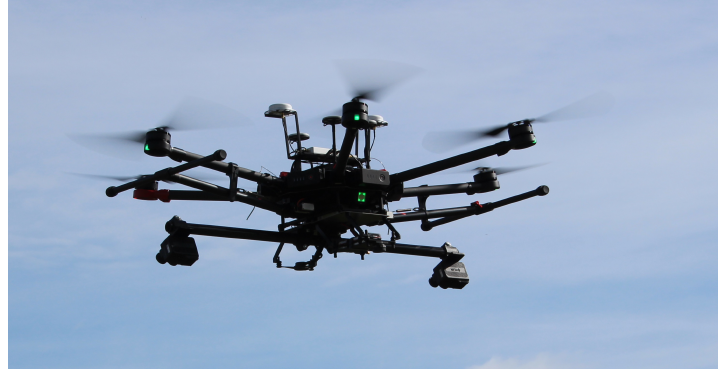
Figure 1. Stereovision system with two multimodal cameras fixed on an M600 DJI unmanned aerial vehicle